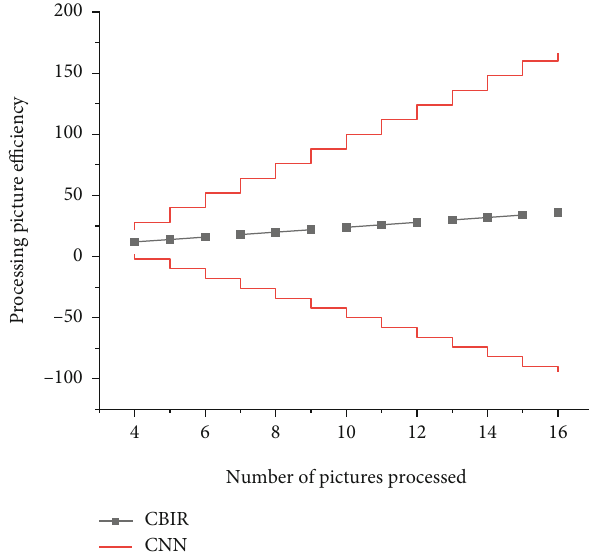
Figure 6: Comparison of similarity feature fi nding e ffi